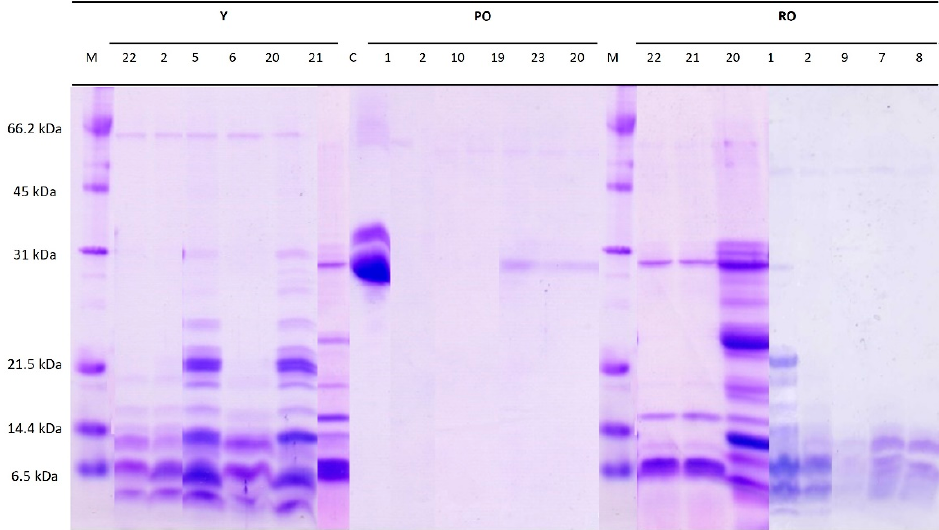
Figure 2. SDS–PAGE electrophoresis of β -casein hydrolyzed by different strains of Y. lipolytica after 72 h of incubation. C: β -casein alone (~31 kDa), M: Protein marker.